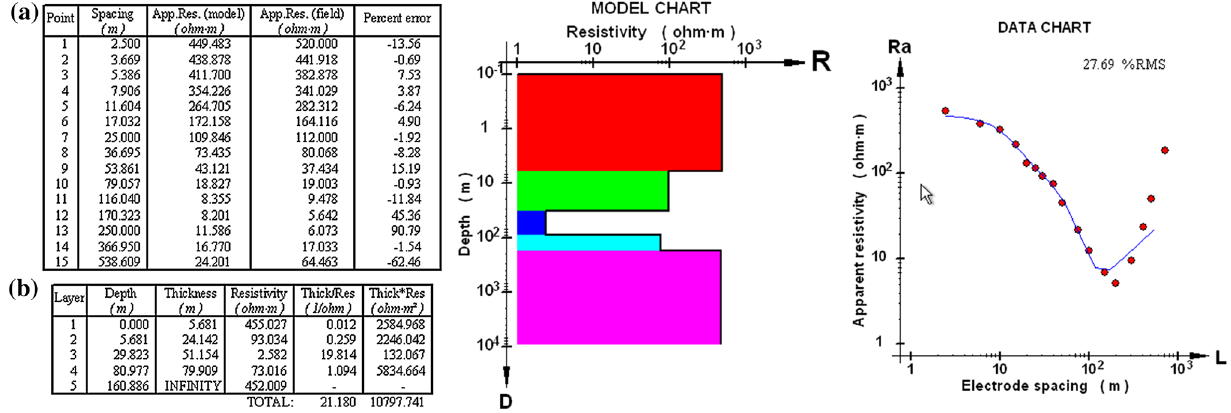
Fig. 5 Inverse modeling (Tables a, b and Charts) for sounding VES6 data-Schlumberger array at